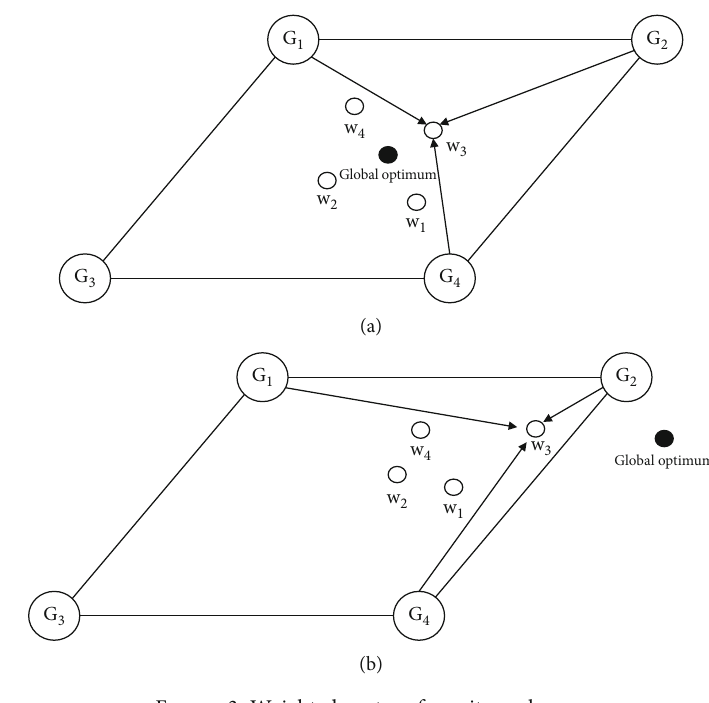
Figure 3: Weighted center of gravity exchange.